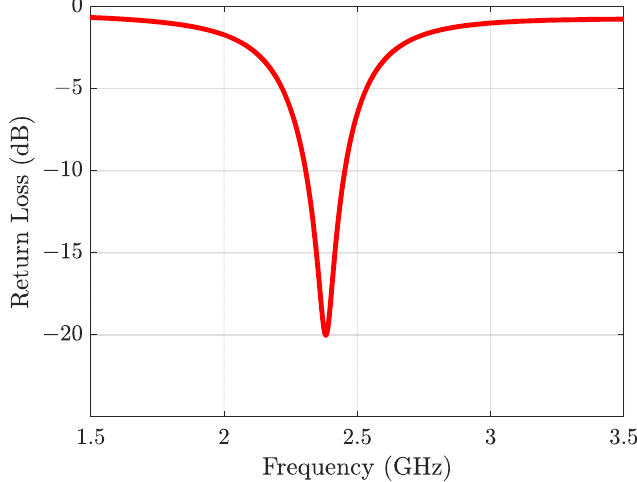
Figure 10. Post layout simulated input reflection coefficient ( S 11 ) of the proposed WuRx.